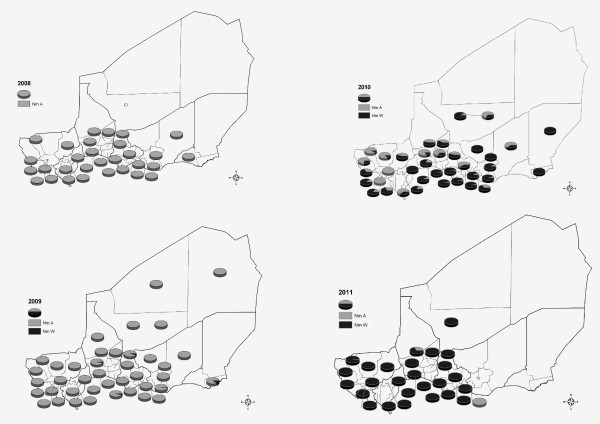
Geographical extension of N. meningitidis serogroup A (Nm A) from 2008 to 2009, its decline from 2010 to 2011 and, in parallel, the extension of Nm W in 2010 and 2011. The proportions of Nm A cases/Nm W cases per district are represented by coloured pie charts.